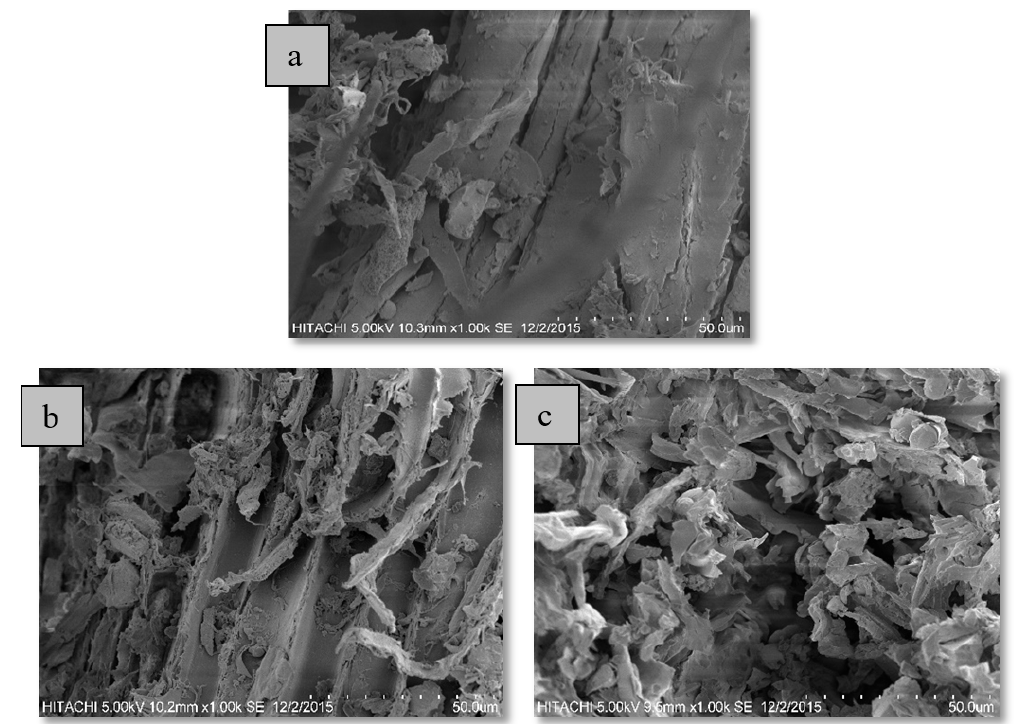
Figure 5. Micrographs of A. malaccensis wood ( a ) before, ( b ) after HD, and ( c ) after SCWE.